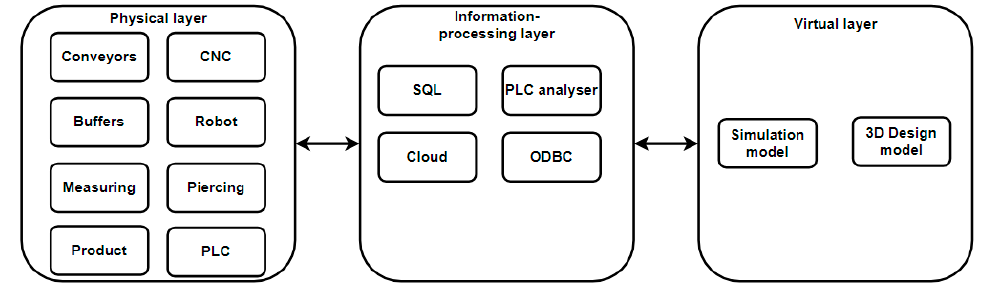
Figure 4. Digital twin mapping diagram between layers.